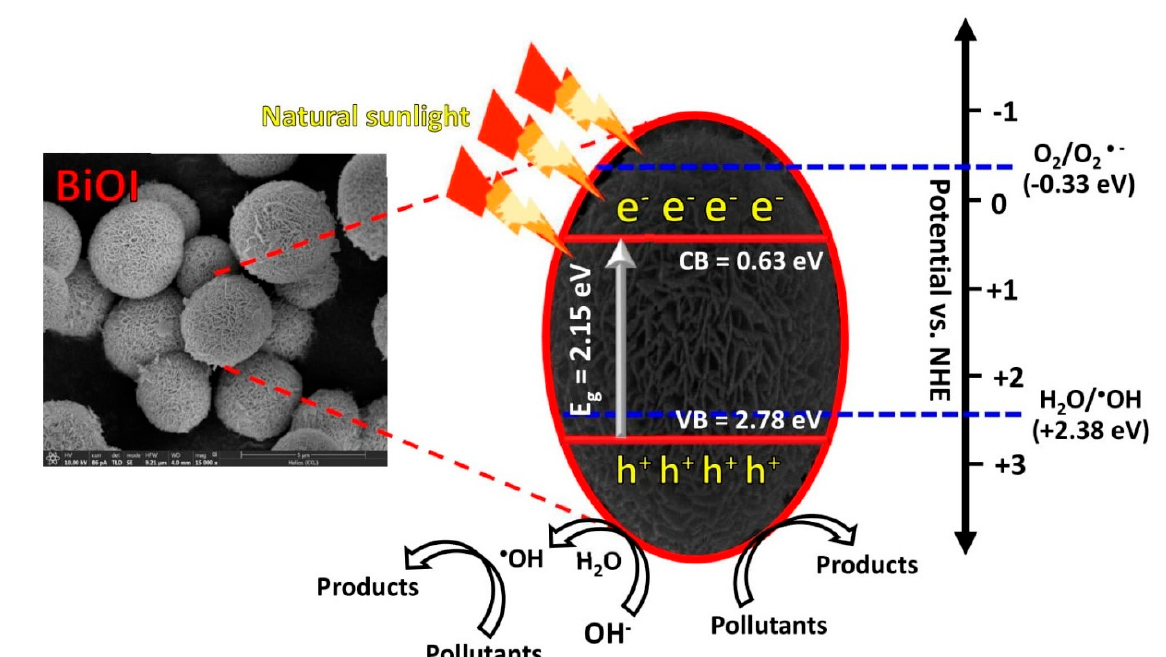
Figure 8. A possible photodegradation mechanism of organic pollutants over BiOI photocatalyst after photo illumination.